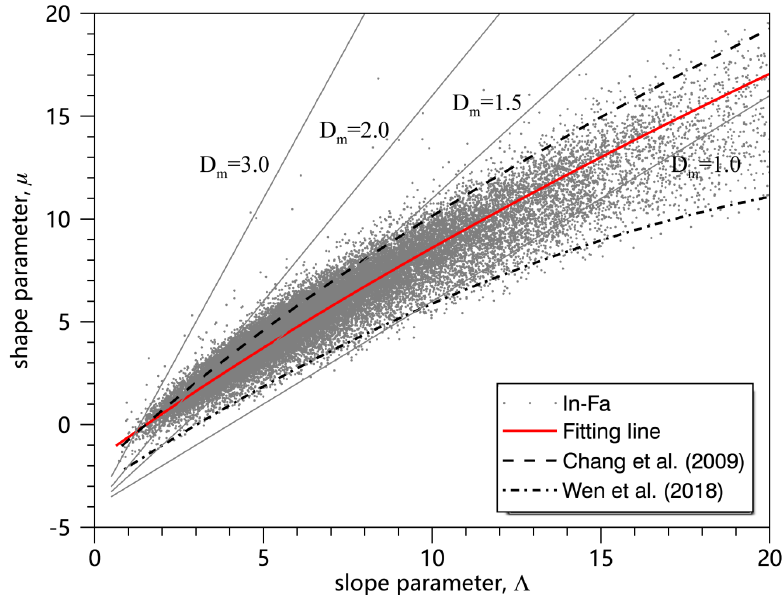
Figure 6. µ - Λ scatter diagram (gray dots) and corresponding fitting curve (red line) based on PARSIVEL disdrometer observations of Typhoon In-Fa (2021). The dashed line represents the empirical µ - Λ relationship of typhoons over Taiwan from Chang et al. [2]. The dash-dot line represents the empirical µ - Λ relationship of typhoons over continental China from Wen et al. [3]. The gray lines correspond to the D m contour according to Λ D m = 4 + µ [30].